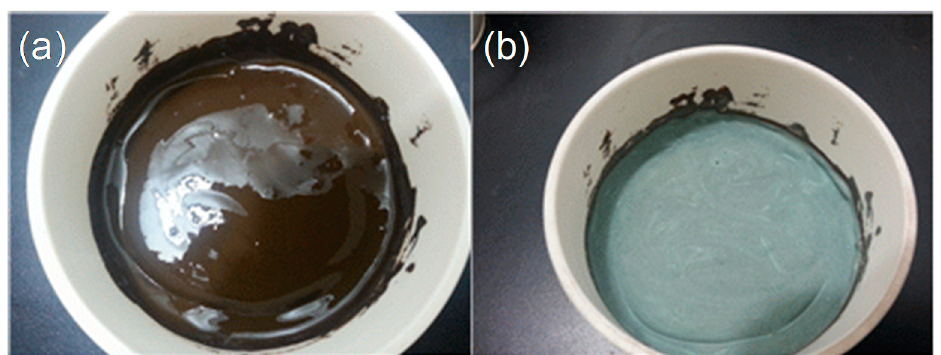
Figure 8. The ore and sulfuric acid mixture ( a ) before and ( b ) after baking at 200 °C for 2 h .